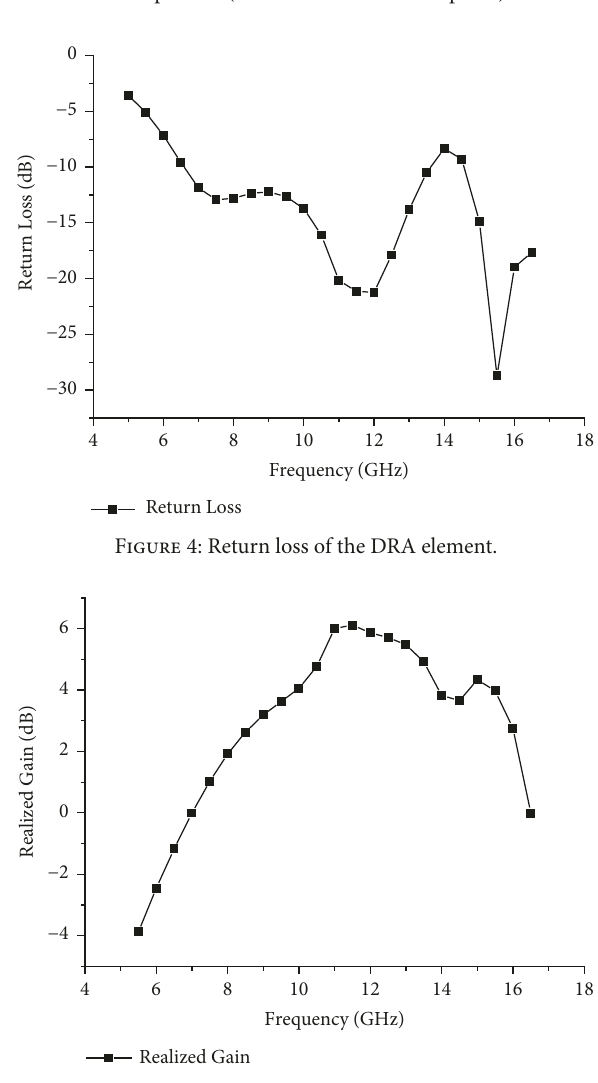
Figure 5: Realized gain of the DRA